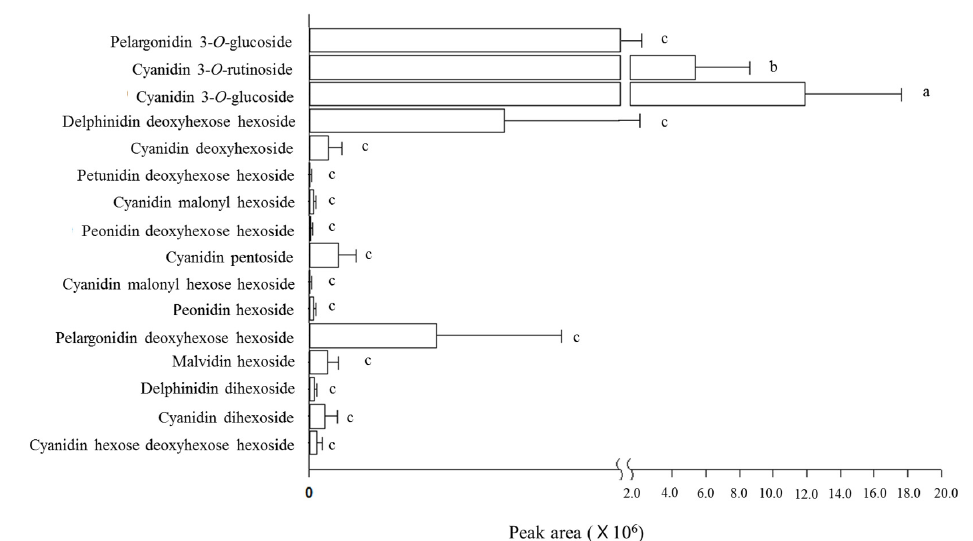
Figure 1. Averages of anthocyanin peak areas determined by UHPLC-(ESI)-qTOF in mulberry fruits of 12 cultivars.